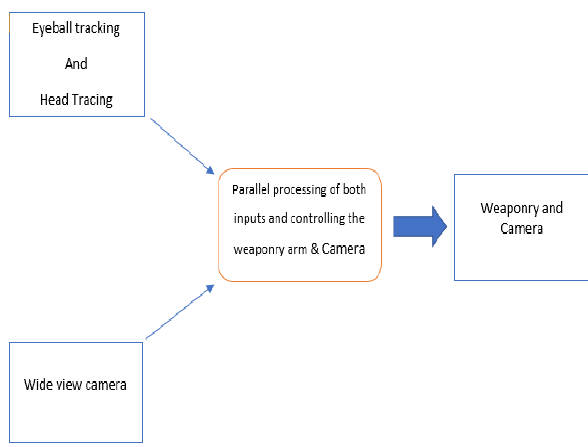
Figure 4. General block diagram of the system